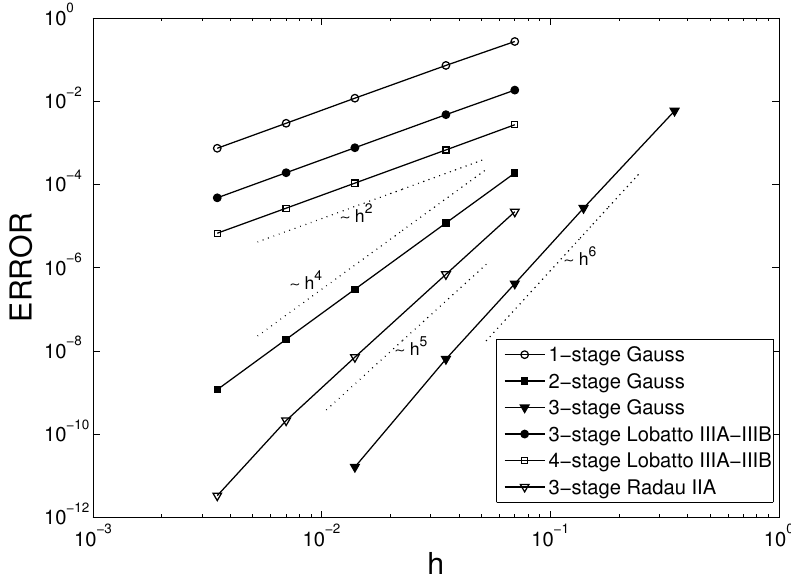
Figure 2. Convergence of several Runge–Kutta methods for Kepler’s